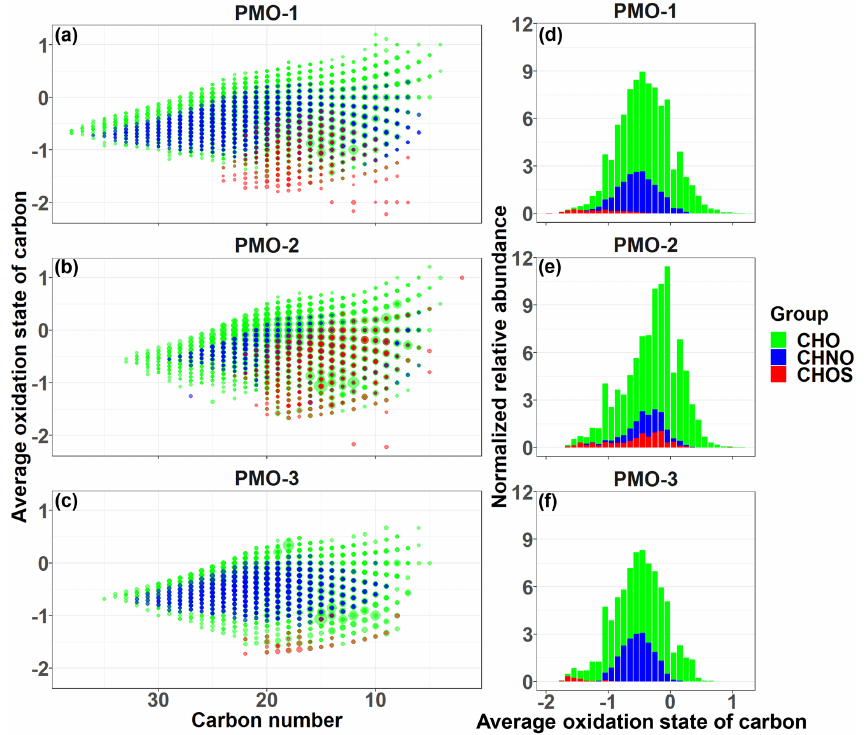
Figure 4. Average OS C vs. carbon number plots for molecular formula identified in each of PMO samples (a–c) . The size of the symbols is scaled to the analyte relative abundance and the color represents the elemental group: CHO (green), CHNO (blue), and CHOS (red). The right panels (d–f) contain average OS C histograms based on the sum of normalized